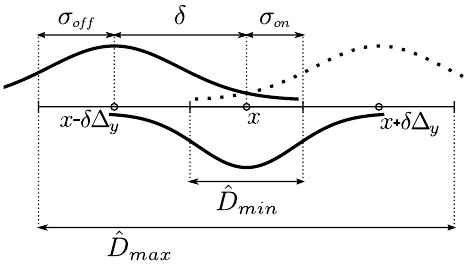
Figure 5. Estimation of the difference of offset Gaussian (DooG) parameters values for the measurement of lumen-to-wall